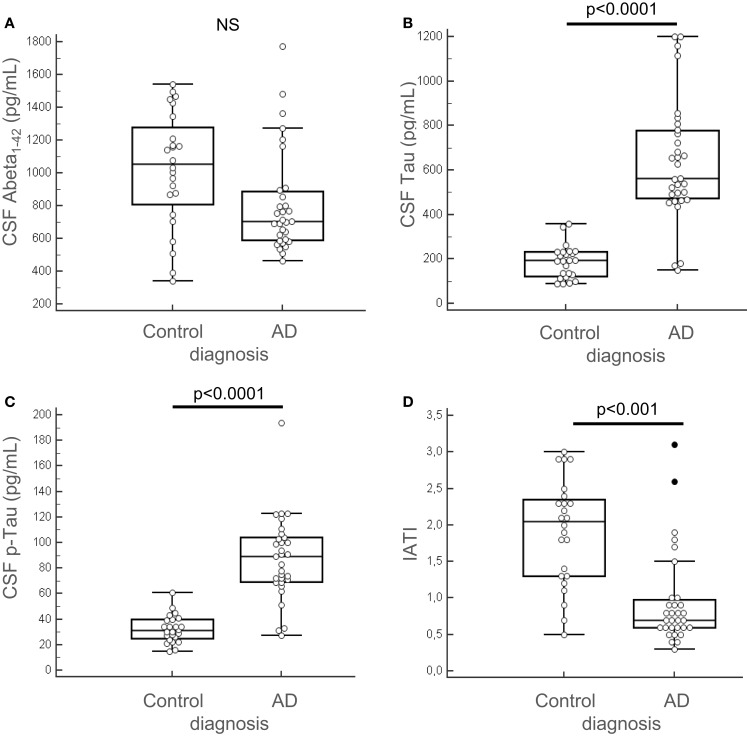
Clinical biochemical characterization of patients. The 55 patients (AD, n = 31 and control subjects, n = 24) of the enlarged cohort used for the second part of the study were characterized clinically and quantified for CSF biomarkers: Aβ42, tau, and p-tau, using Fujirebio ELISA quantification kits (A–C). IATI ratio [Aβ42/(240 + 1,18tau)] (D) was calculated for every subject of the cohort. Outliers are indicated with black circle. Outliers are defined as a value that is smaller than the lower quartile minus three times the interquartile range, or larger than the upper quartile plus three times the interquartile range.